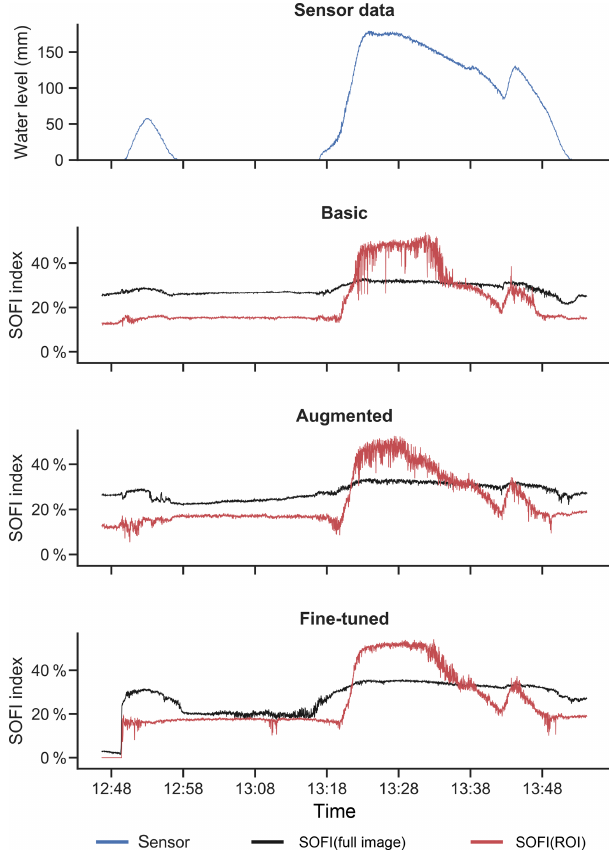
Figure 6. Water level (blue) and SOFI signal for the whole image (black) or the region of interest (ROI, red) for the FloodXCam5 video. With more advanced DCNN training strategies, noise and outliers in SOFI are visibly reduced in the ROI. The time series for the remaining videos can be found in the Supplement (Figs. S2–S6). All time references on the x axis refer to local time.